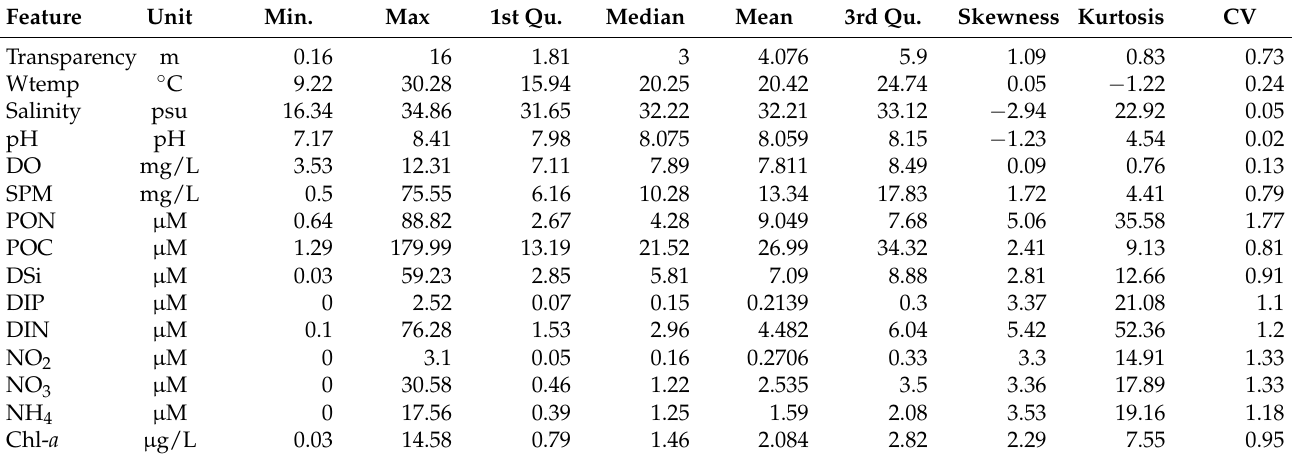
Table 2. Imputed complete data summary ( n = 729). Abbreviations: 1st Qu., 1st quartile; 3rd